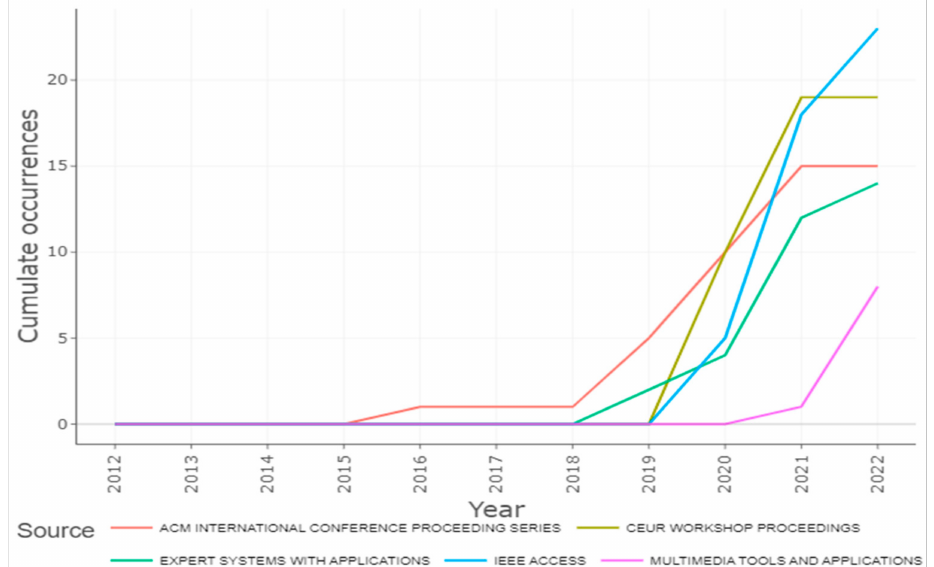
Figure 10. Dynamics of